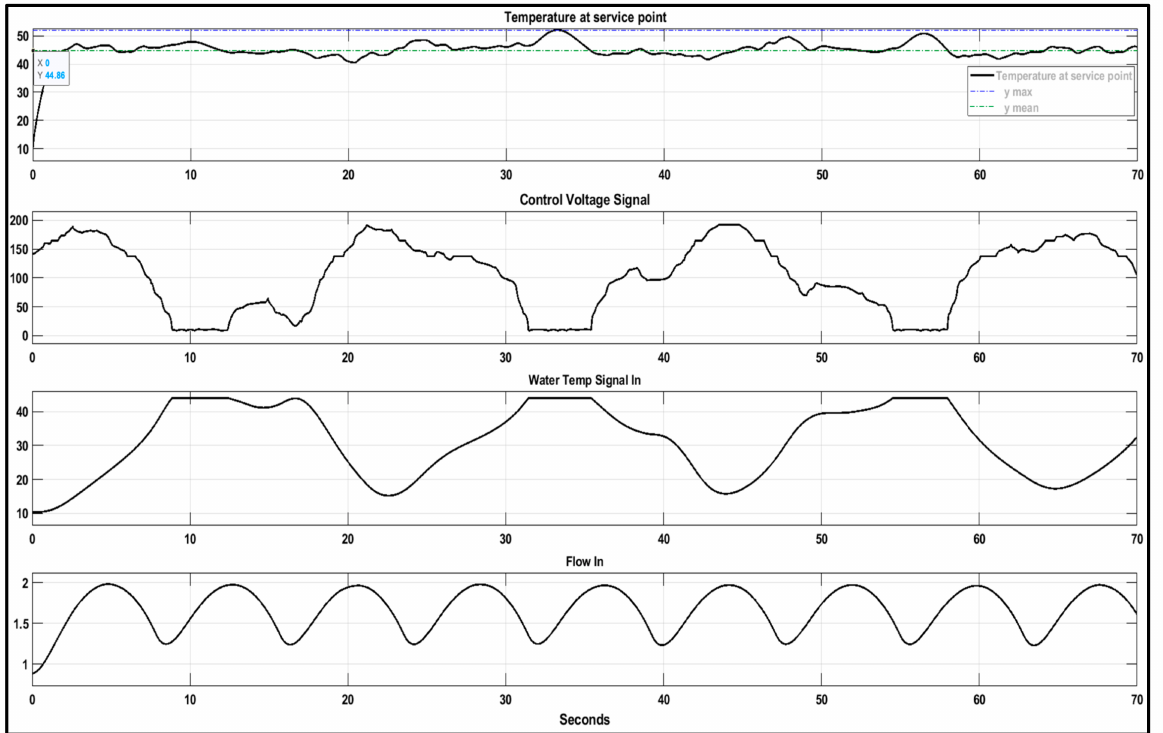
Figure 7. Nonlinear “Slow” flow fluctuation performance of the fuzzy controller.